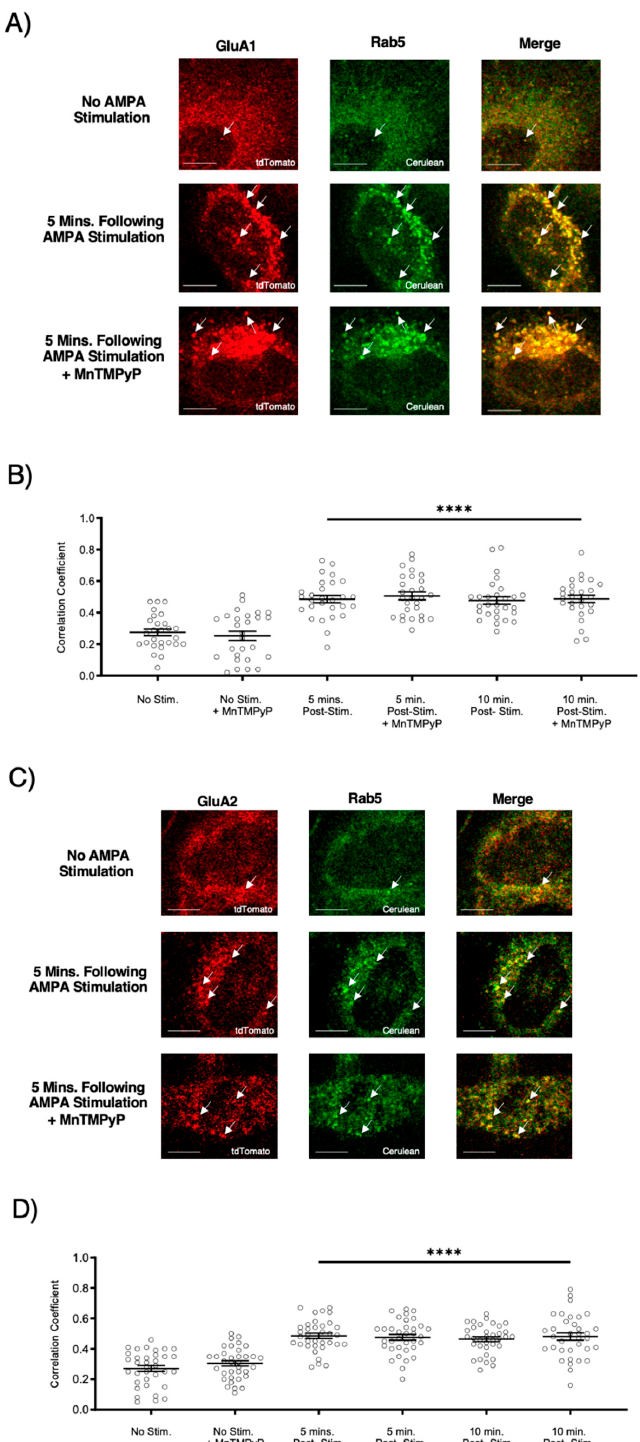
Figure 2. Pretreatment with Mn(III)tetrakis(1-methyl-4-pyridyl)porphyrin (MnTMPyP) did not prevent agonist-induced internalization of AMPARs. U251-MG cells transfected with either GluA1-tdTomato or GluA2-tdTomato and Rab5-cerulean, an early endosomal marker, and stimulated with AMPA agonist [100 µM]. ( A , B ) Increased colocalization between GluA1 and Rab5, and GluA2 and Rab5, respectively. This indicates internalization following agonist stimulation, which was unaffected by pretreatment with MnTMPyP, a superoxide scavenger. ( C , D ) are quantifications of ( A , B ), respectively (n = 30). **** p < 0.0001; ANOVA with Tukey’s post hoc test comparing agonist conditions to corresponding controls (no agonist stimulation ± MnTMPyP). Data are expressed as mean ± SEM. Scale bar is 100 µ M. Arrows indicate